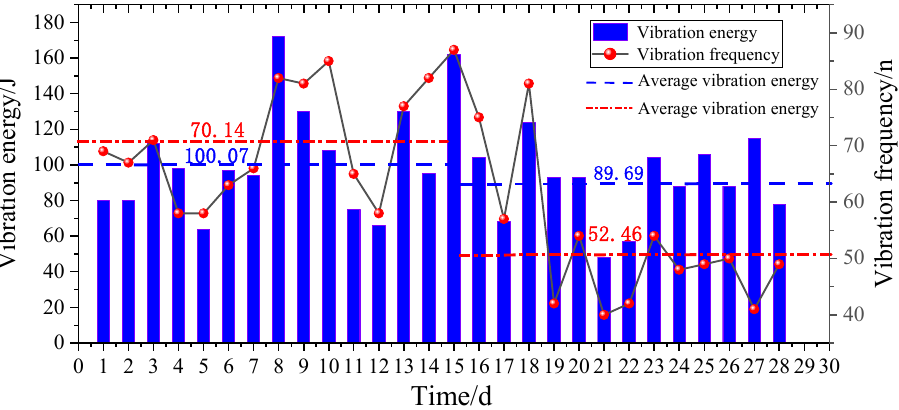
Figure 21. Characteristics of the borehole peep hole.